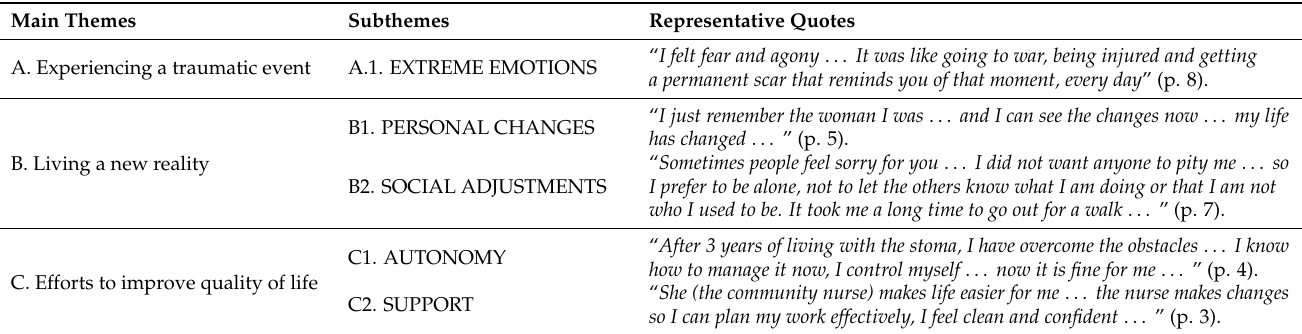
Table 2. Main Themes and